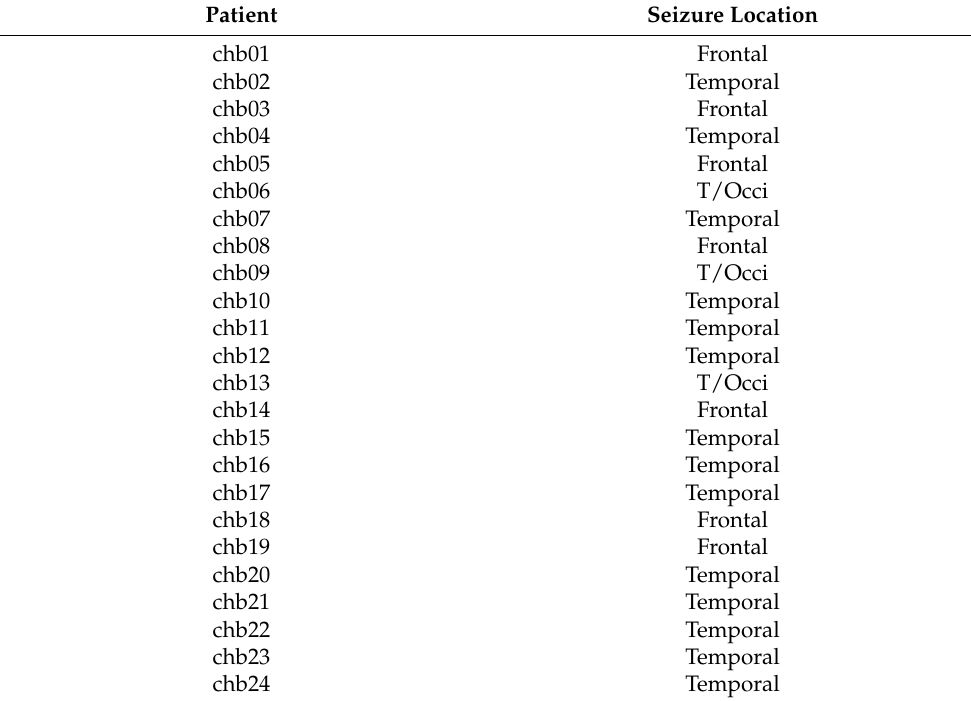
Table 4. Location of seizure.